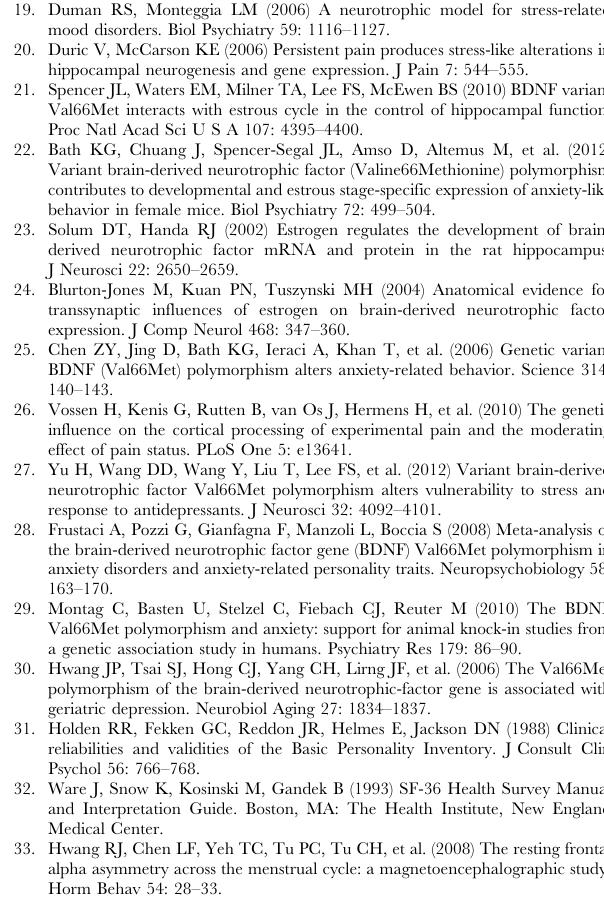
Table S2 Results of repeated-measures ANOVA of psychological measurements: effects of menstrual cycle and BDNF genotype in the control group. Table S3 Results of repeated-measures ANOVA of quantitative sensory testing: effects of group, BDNF genotype and menstrual cycle. Table S4 Results of repeated-measures ANOVA of gonadal hormone levels: effects of group, BDNF geno- type and menstrual